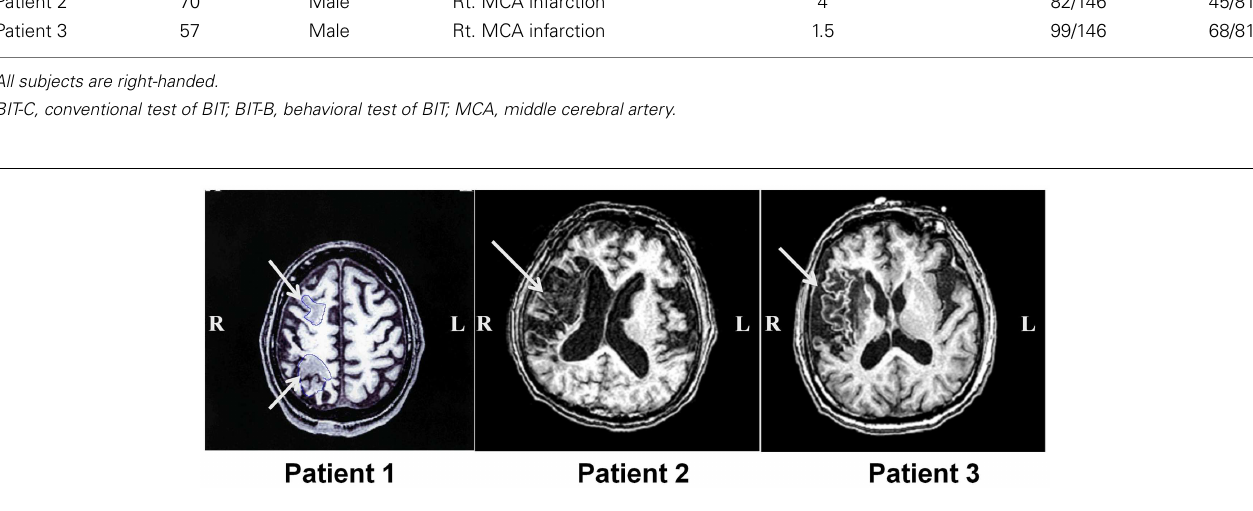
FIGURE 1 | Lesion location in patients with unilateral spatial neglect .T1-weighted magnetic resonance images for all three patients with unilateral spatial neglect.White arrows indicate